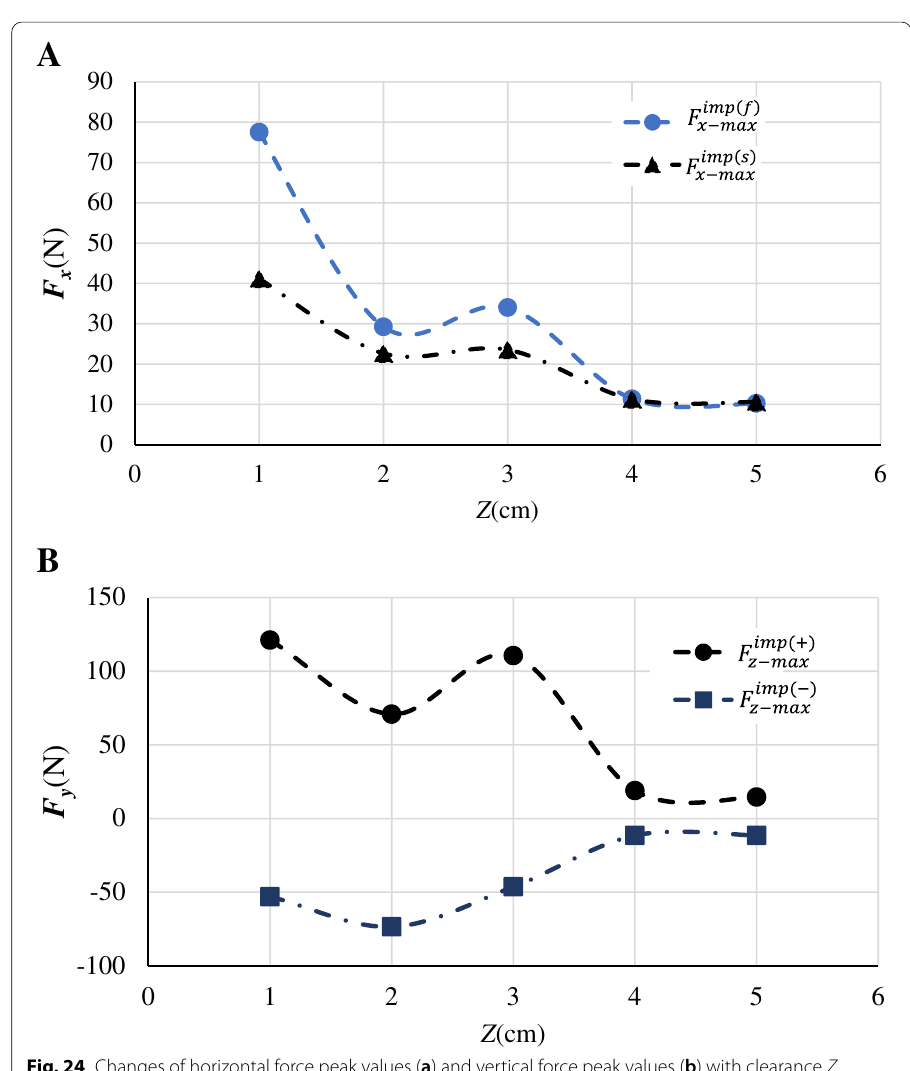
Fig. 24 Changes of horizontal force peak values ( a ) and vertical force peak values ( b ) with clearance